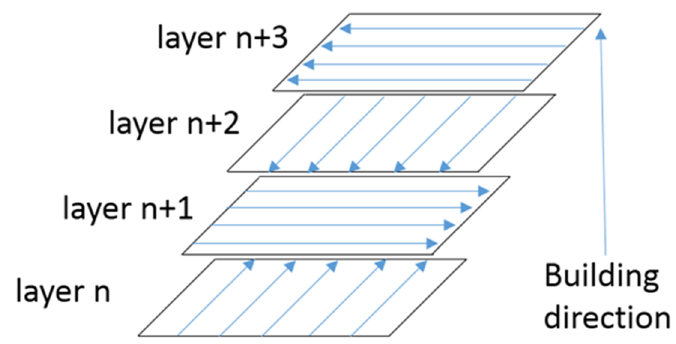
Figure 4. Schematic illustration of the laser scanning pattern: “orthogonal scanning strategy”. Table 1. The list of SLM processing parameters.